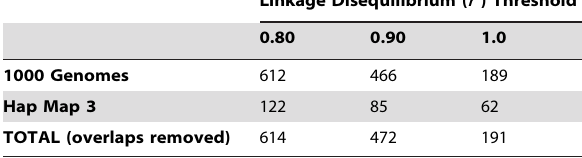
Table 1. Number of SNPs in linkage disequilibrium for all published GWAS SNPs for HapMap3 and 1000 Genomes populations at tested r 2